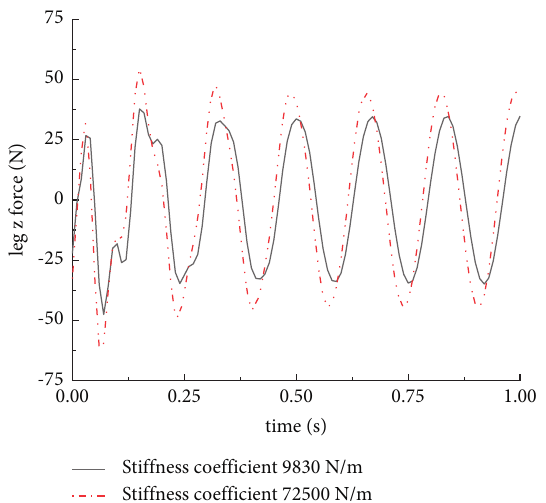
Figure 18: The force of branch 1 (constant stiffness coefficient 9830N/m).